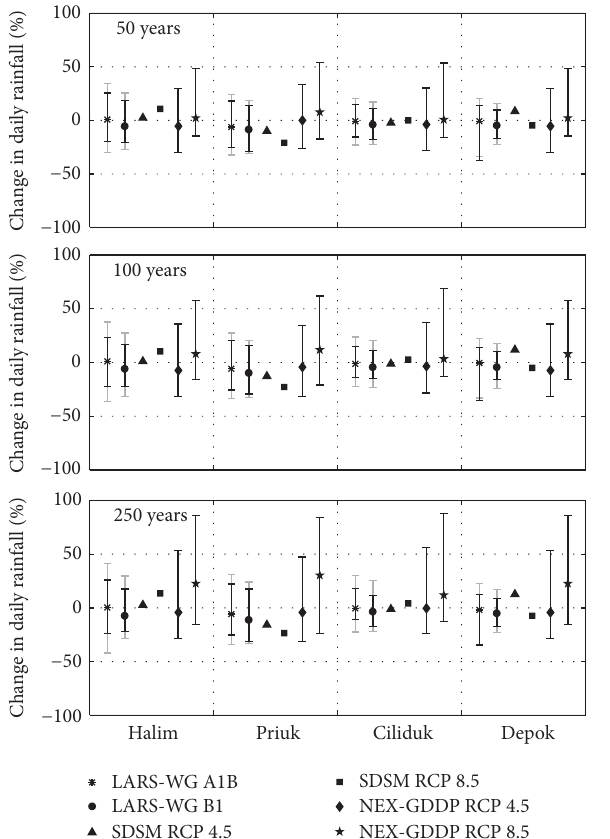
Figure 13: Same as Figure 11 but for dry season (June to